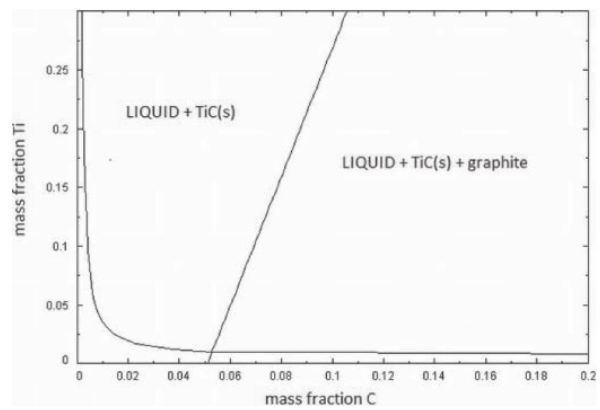
Fig. 16: Fe-Ni9mass%-Ti-C system at 1823